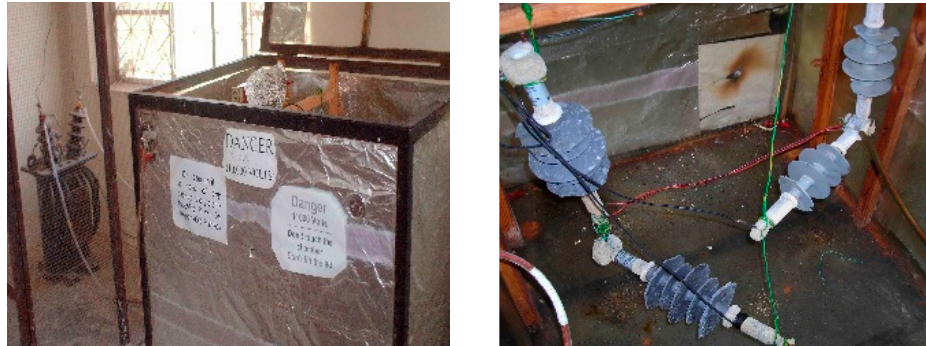
Figure 1. Schematic & photographs of the experimental setup.